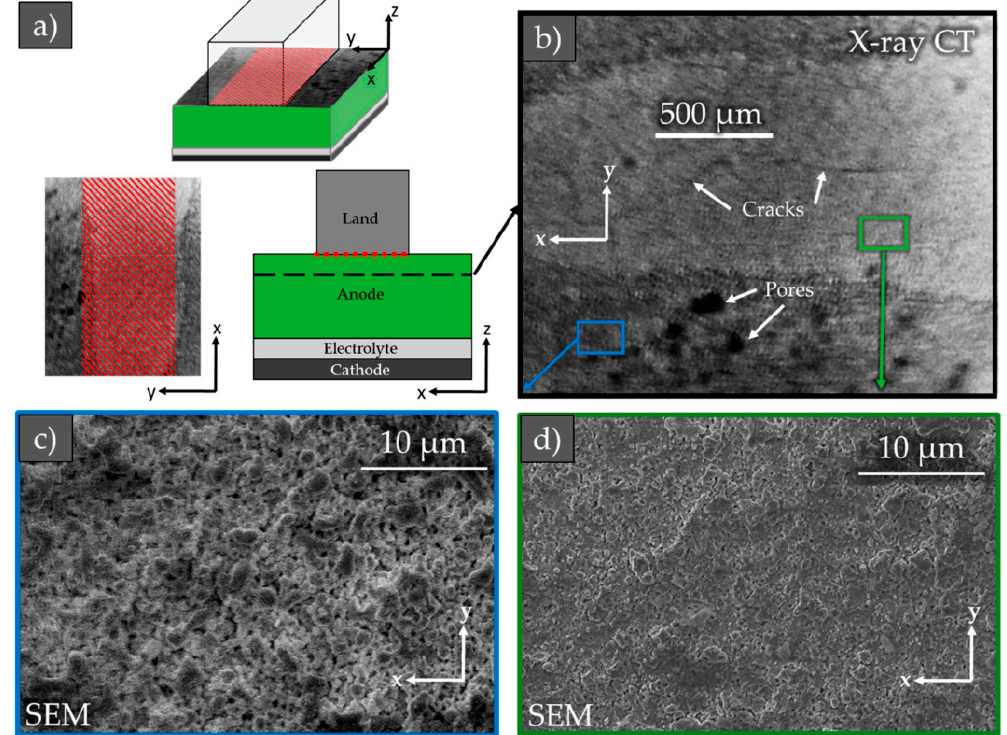
Figure 1. ( a ) Geometric reference for X-ray and electron imaging; ( b ) a subsurface ortho-slice image taken from an X-ray CT tomogram; ( c ) SEM image of the Ni-dominated channel; ( d ) SEM image of the NiO-dominated land [2].